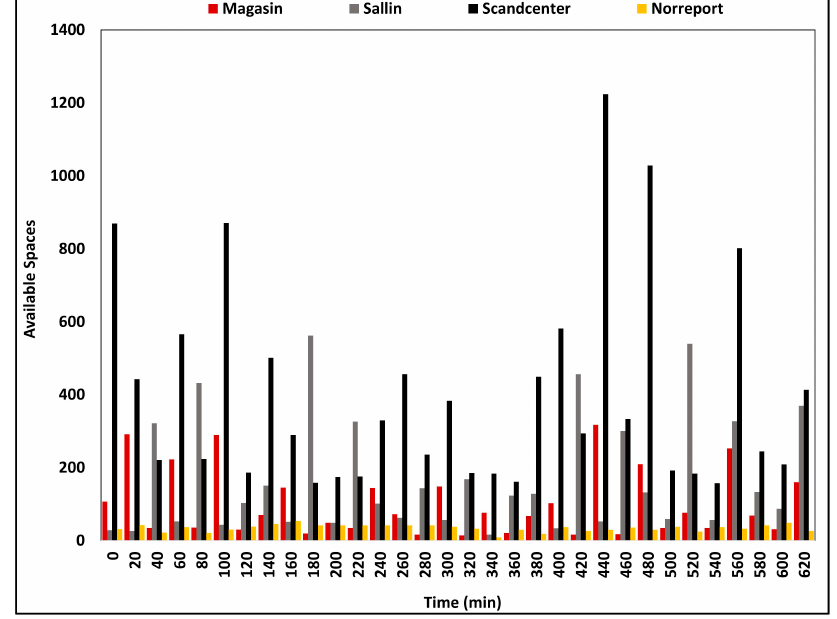
Figure 7. Parking lot availability of Aarhus City, Denmark.